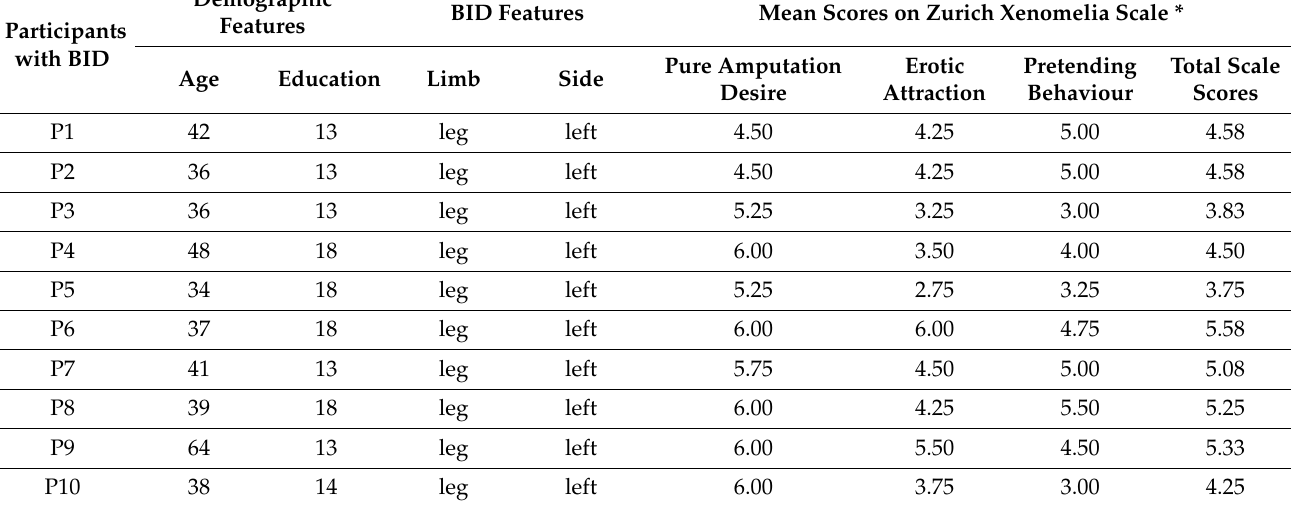
Table 2. Demography and clinical features of participants with BID. * Range